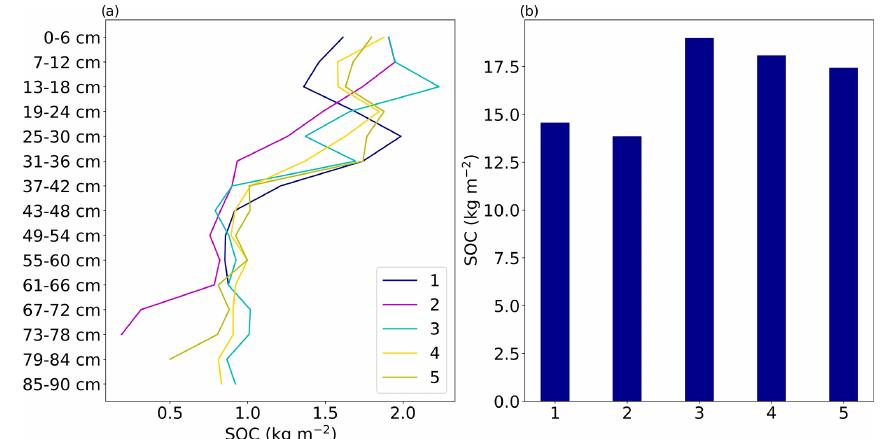
Figure 7. (a) Soil organic carbon (SOC) content at different depths in the 1m deep soil samples, and (b) the total SOC in the samples. Numbers from 1 to 5 indicate sample